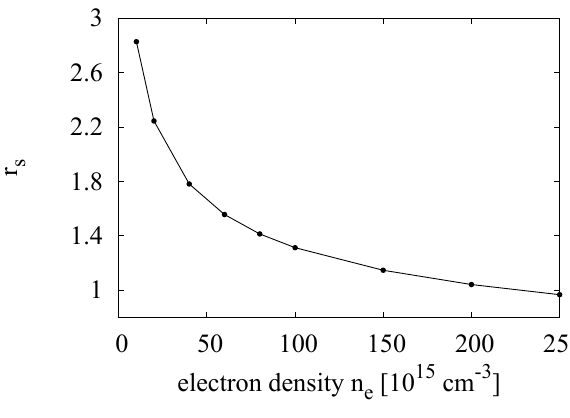
versus the electron density for an n-GaAs. The range of RPA s lesser than s